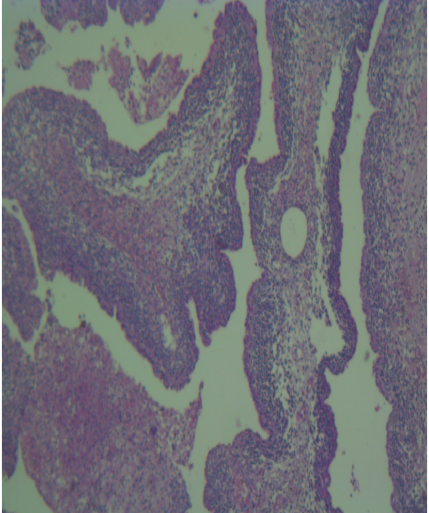
Figure 5: Photograph of pneumoblastoma type II showing a multicystic structure with the epithelial